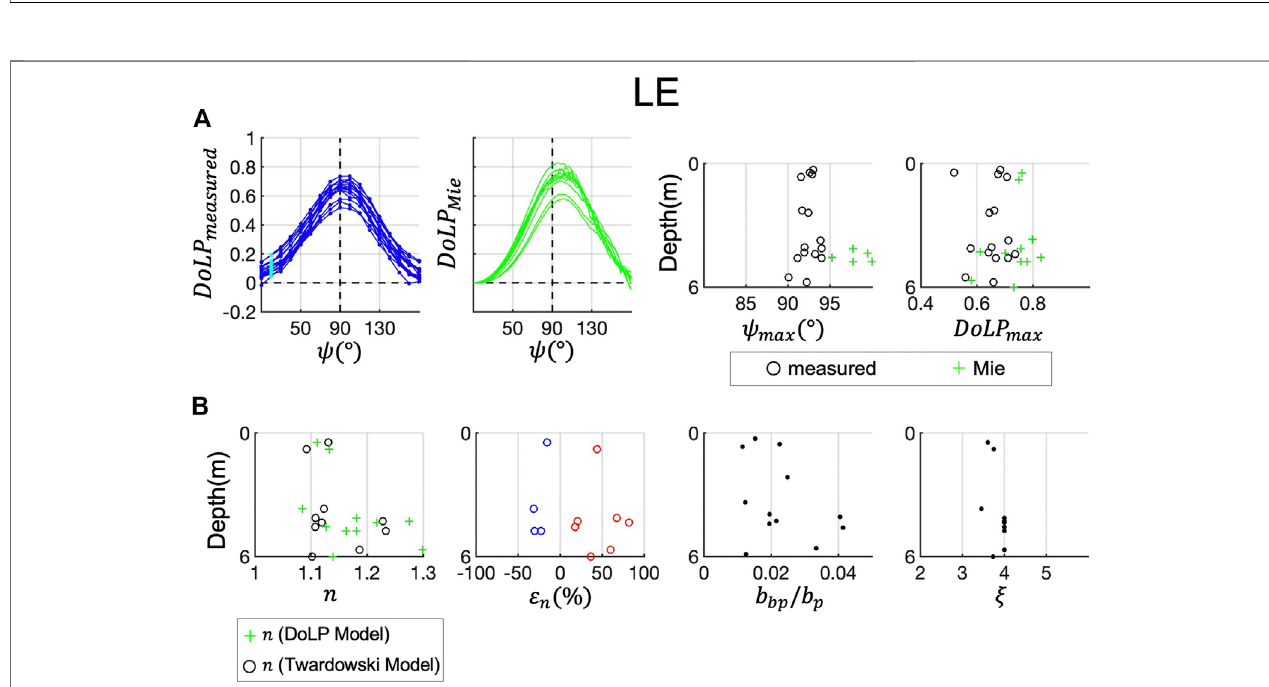
FIGURE 11 | Refractive index retrieval at fi eld site LE (Lake Erie). Same as Figure 9 .